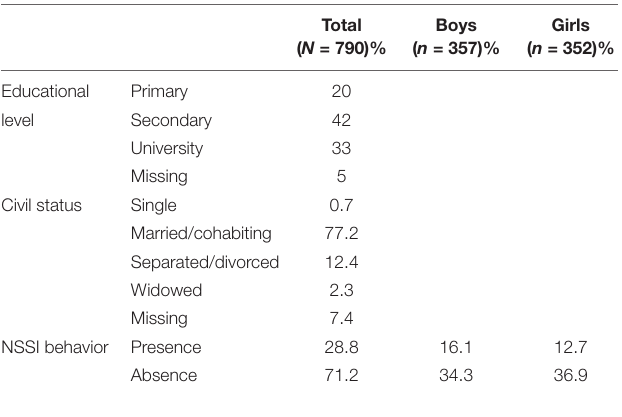
episode of NSSI and 97 of them (13.7%) reported more than one episode with at least two different methods while only1.4% reported engaging in repetitive NSSI ( ≥ 5 episodes) during the last year. Detailed results are reported in Table 1 . No the presence or absence of NSSI